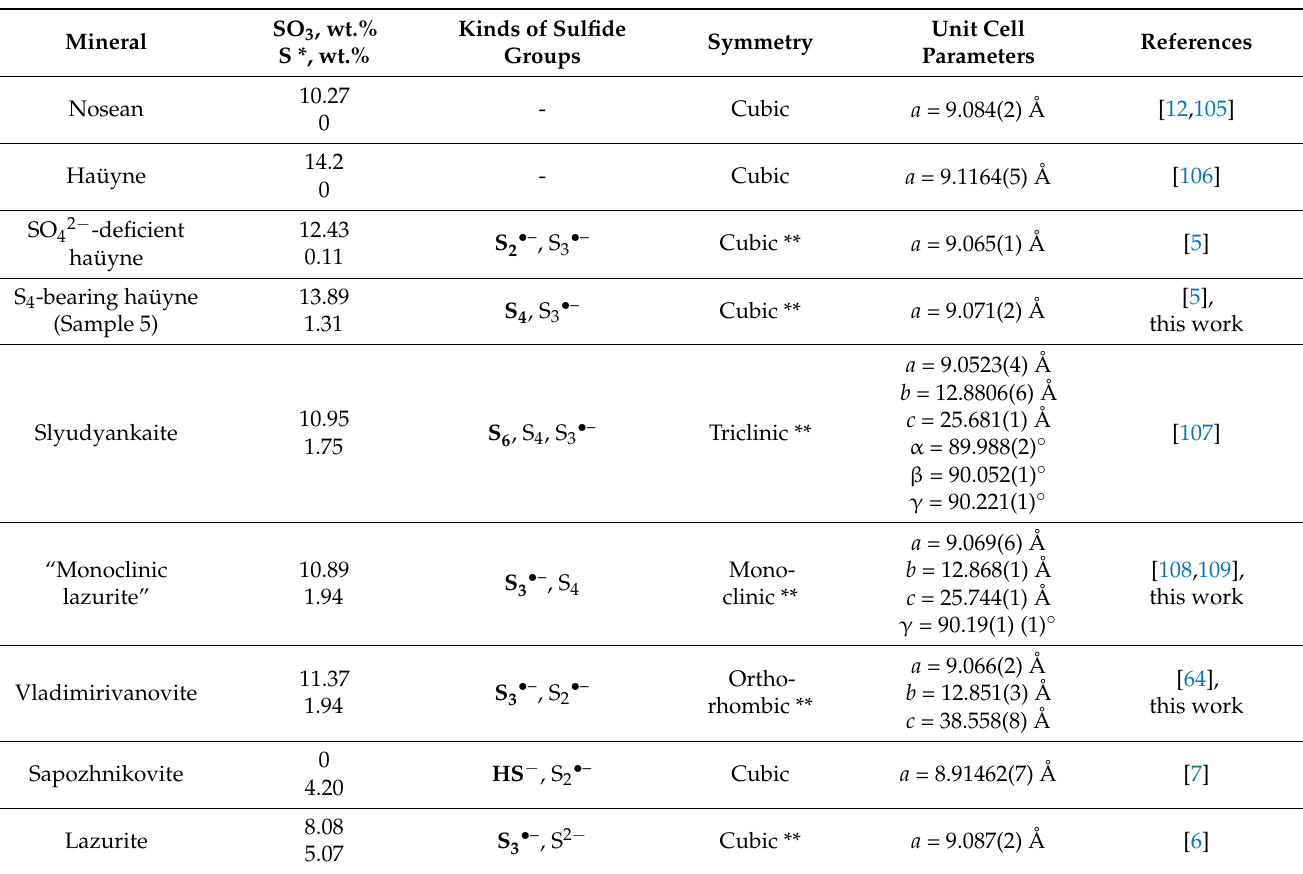
Table 7. Data on S-bearing sodalite-group